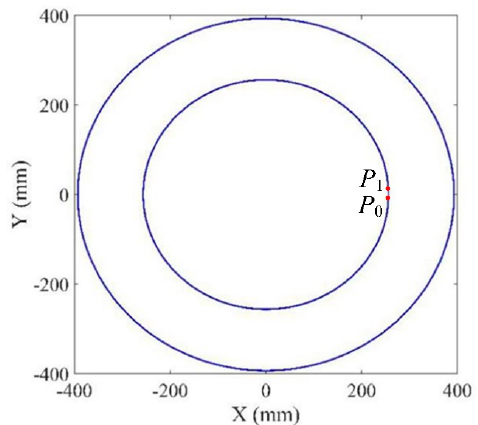
Figure 12. The boundary extracted by the method in this paper.